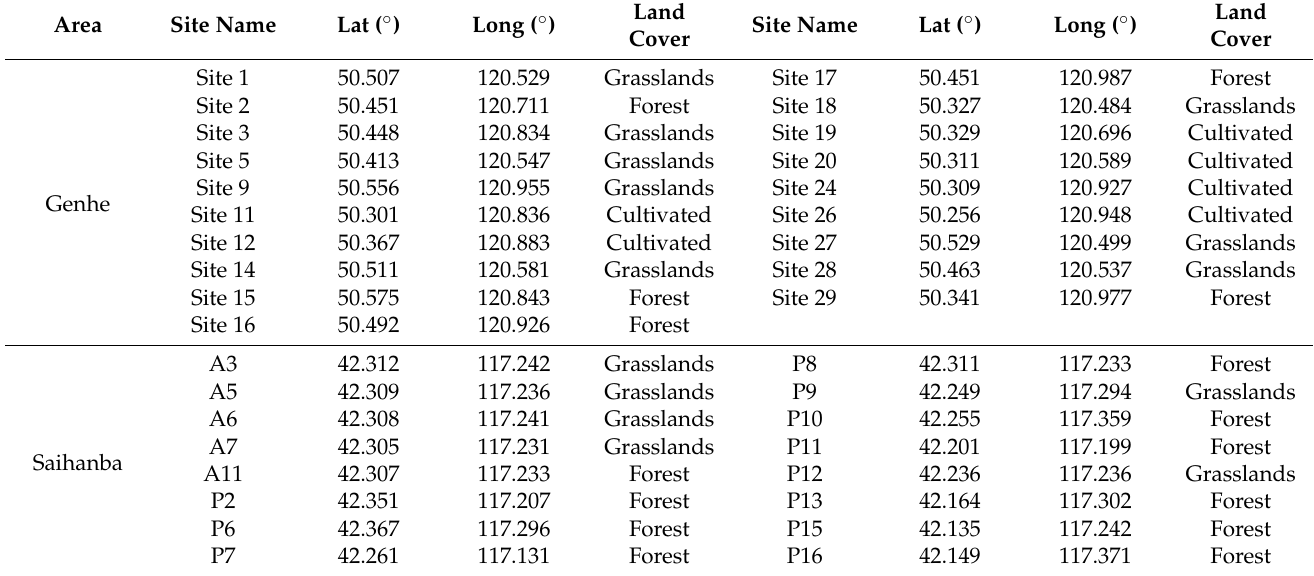
Table 1. Coordinates and land cover type of the in situ